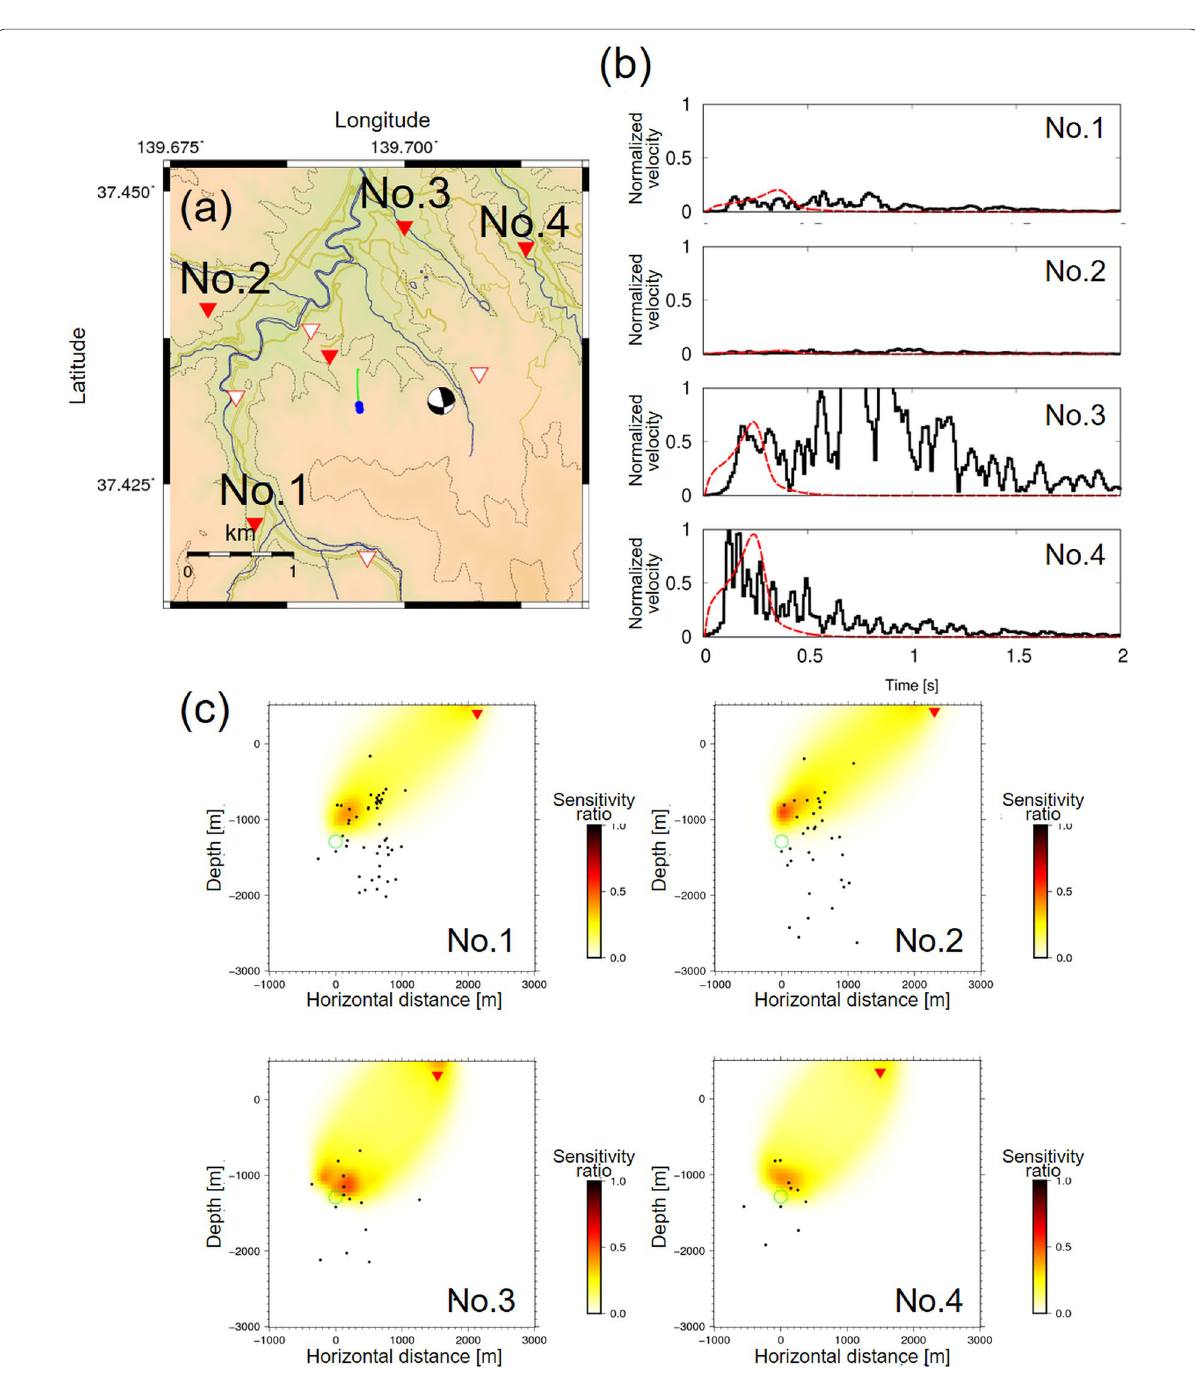
Fig. 2 Example of scattering analysis. a Location of the earthquake used for the example of scattering analysis; b observed (black line) and theoreti- cal (red dashed line) waves; c sensitive area of initial P -waves for this example case projected on cross section including hypocenter (shown as circle) and receiver (shown as inverted